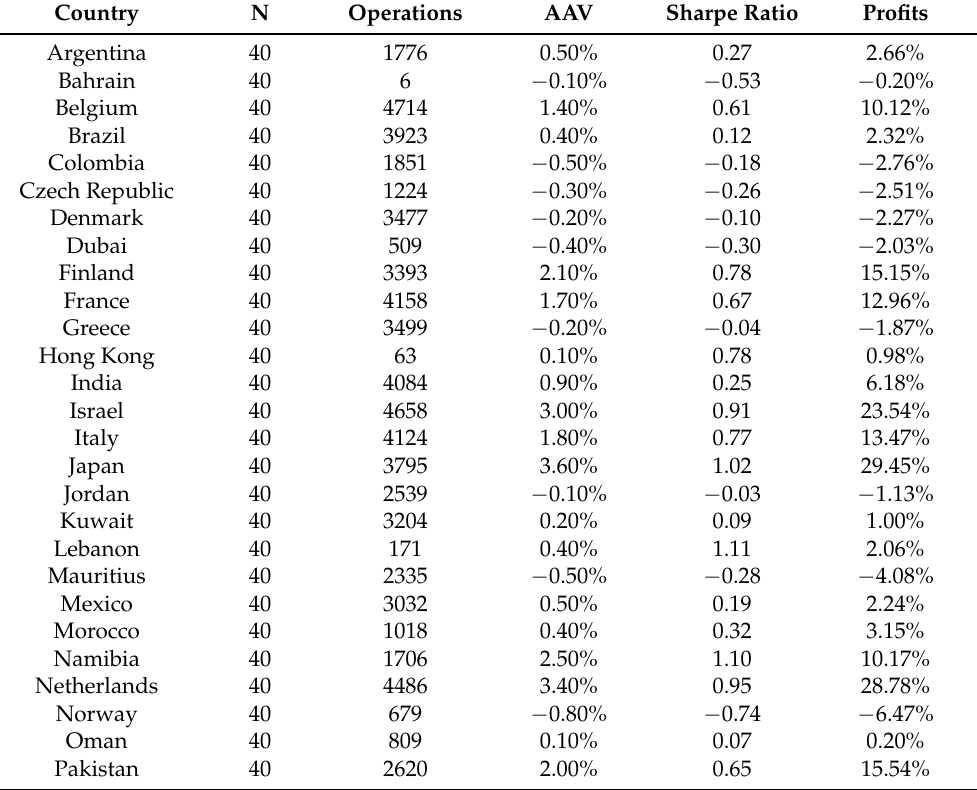
Table A3. Results obtained for the period 2000–2007 (40 Pairs), where N is the number of pairs; AAV Average annualized return; and Profit is the profitability for the full period with transaction